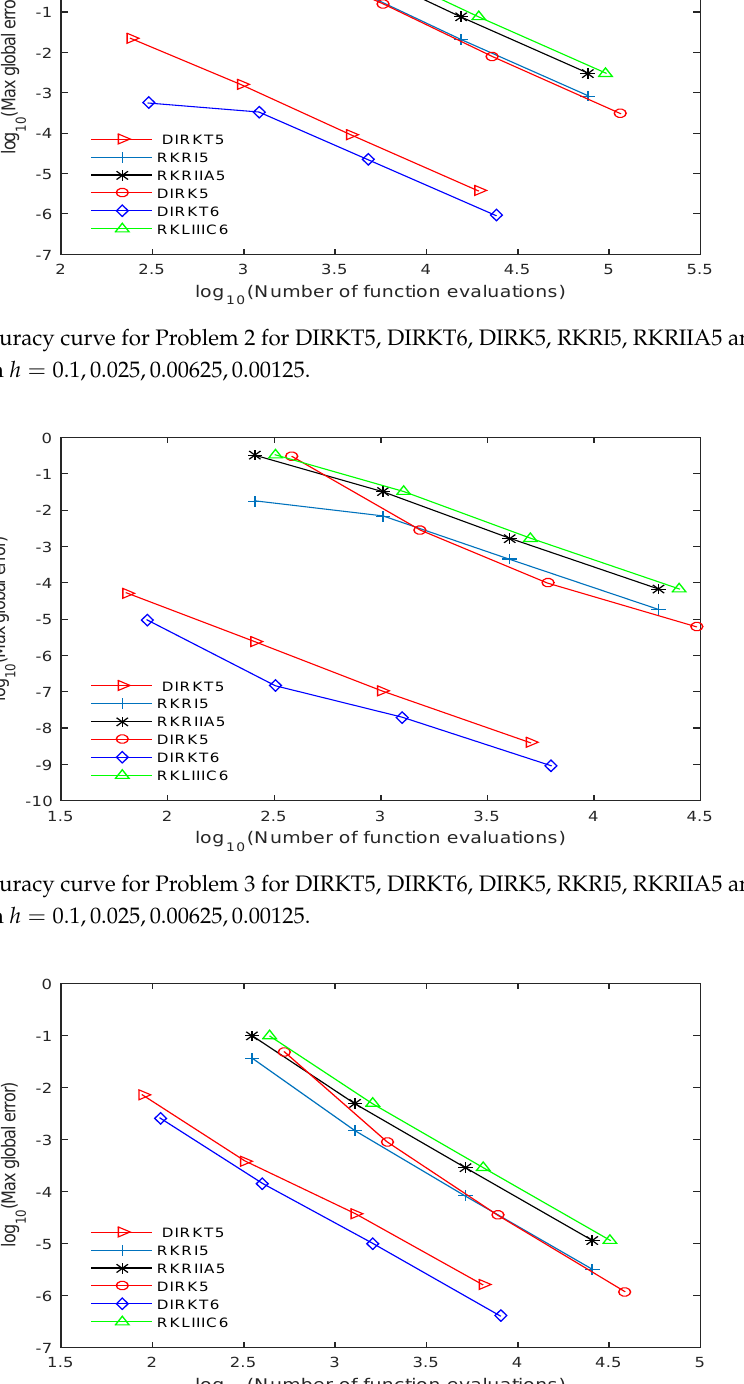
1.5 log (Number of function evaluations) 10 Figure 4. Accuracy curve for Problem 4 for DIRKT5, DIRKT6, DIRK5, RKRI5, RKRIIA5 and RKLIIIC6 methods with h =